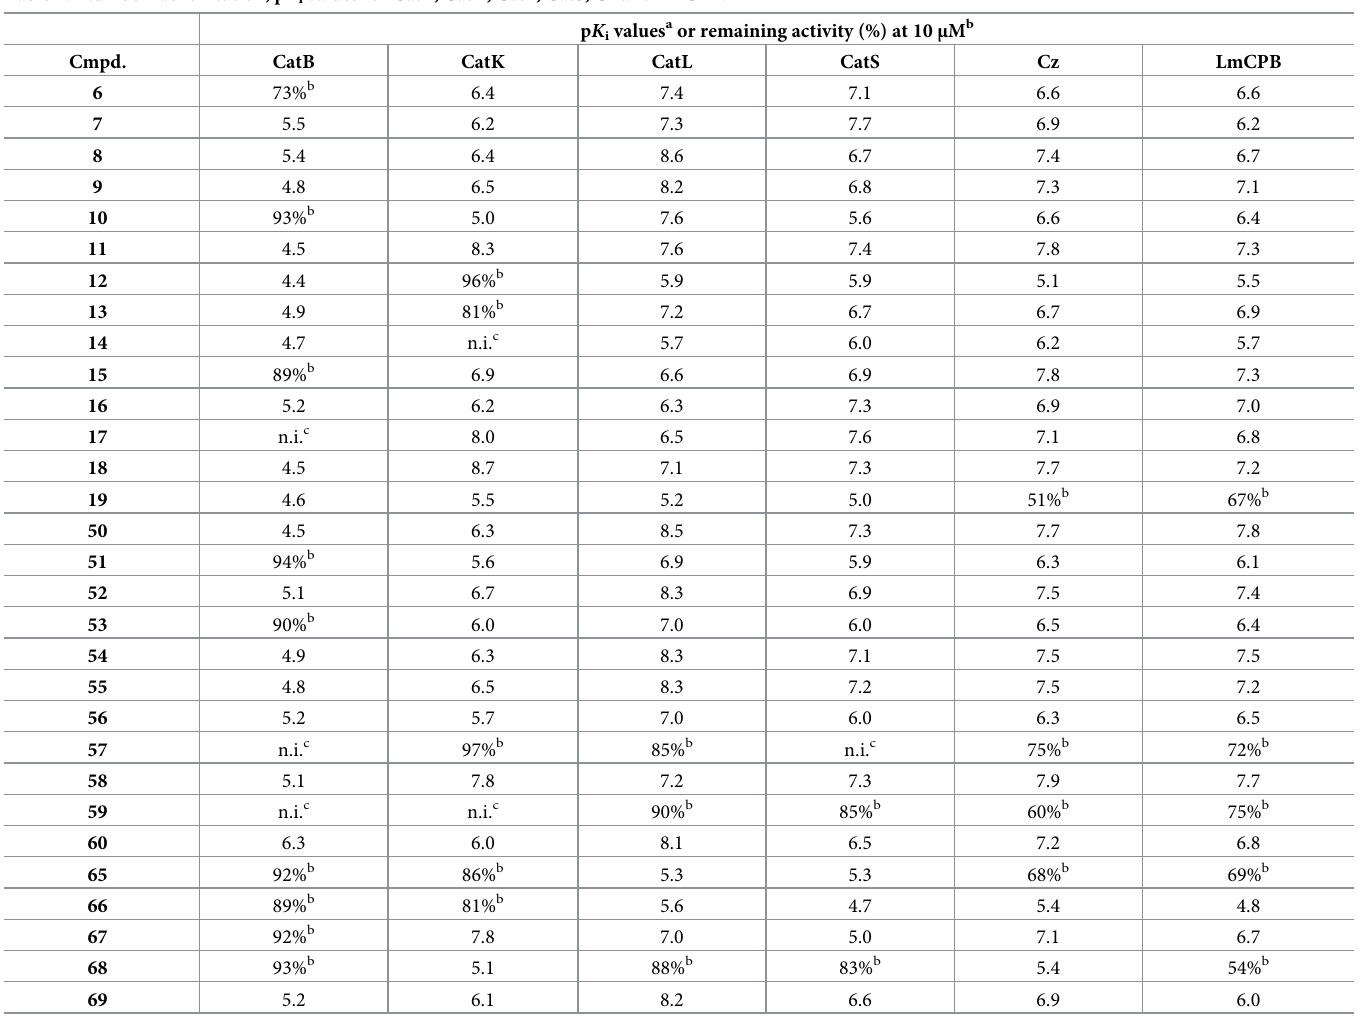
Table 1. Number identification, p K i values for CatB, CatK, CatL, CatS, Cz and LmCPB.